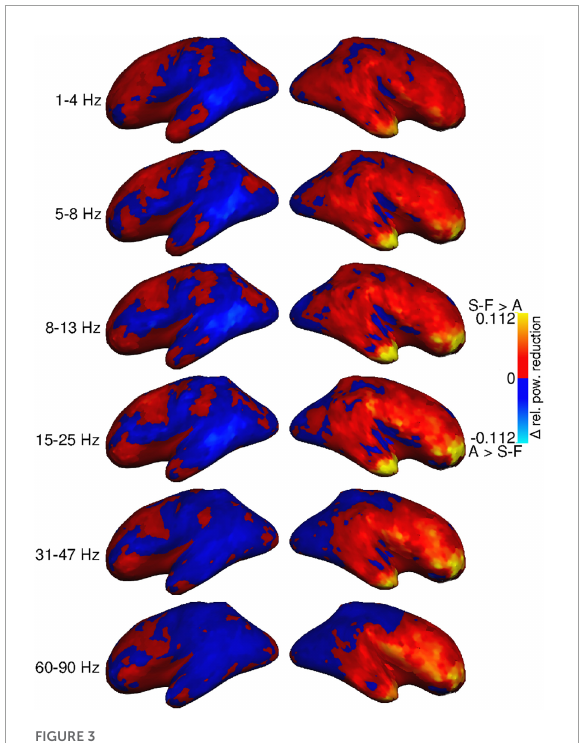
FIGURE3 Group-level difference between power reduction by SOBI-FastICA and AMICA, relative to the power level of the AMICA pipeline. Red indicates areas where the SOBI-FastICA pipeline resulted in a larger reduction of signal power, whereas blue denotes areas where AMICA resulted in a larger reduction of signal